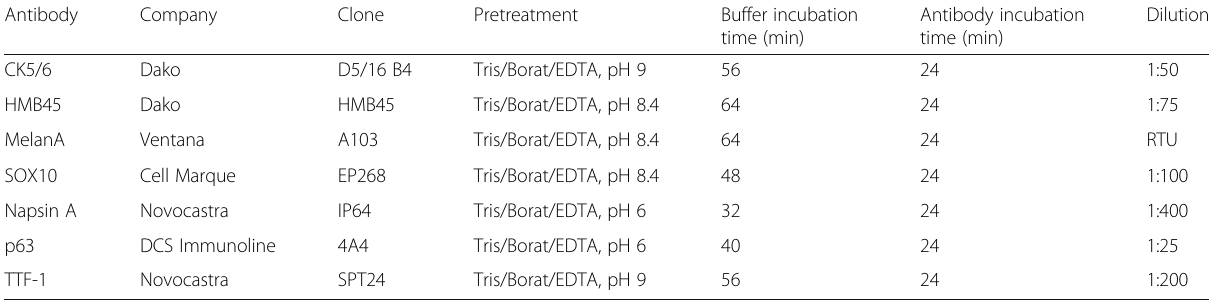
Table 2 Antibodies used in this study and staining conditions